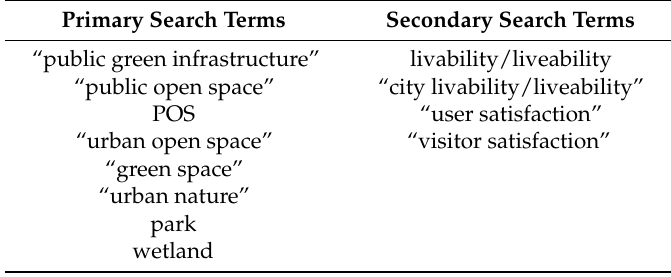
Table 1. Search terms used to identify papers included in the literature review. Potential papers were filtered using the primary AND secondary search